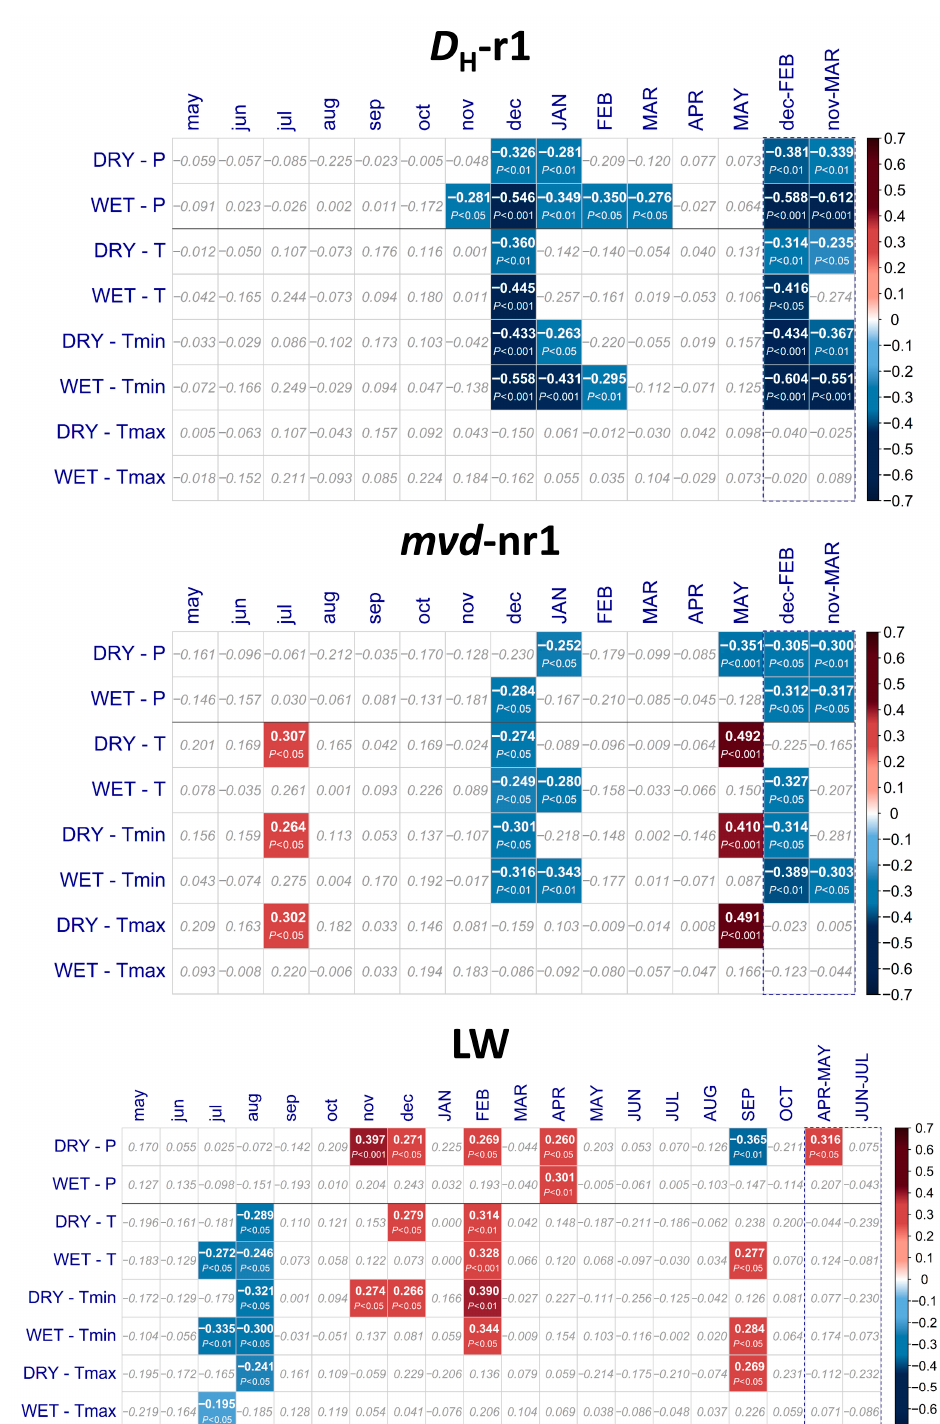
Figure 3. Climate–growth relationships for the earlywood ( D H -r1 and mvd -nr1) and latewood (LW) chronologies for the period 1956–2013 (58 years); results are expressed as Pearson’s correlation coefficients, with their significance obtained by 10,000 bootstrap replications. Only significant correlations are highlighted. D H -r1: hydraulically weighted diameter of the first row; mvd -nr1: mean vessel diameter of vessels not belonging to the first row; LW: latewood width; P : total precipitation; T : mean temperature; Tmin : mean of minimum daily temperatures; Tmax : mean of maximum daily temperatures. Lower and uppercase letters correspond to the months of the previous and current growth years, respectively; climate variables are expressed as monthly records.